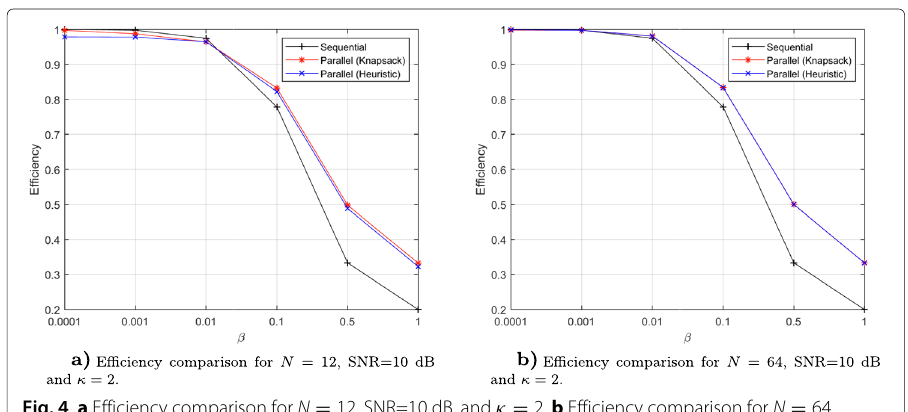
Fig. 4 a Efficiency comparison for N = 12, SNR=10 dB, and κ = 2. b Efficiency comparison for N = 64, SNR=10 dB, and κ = 2